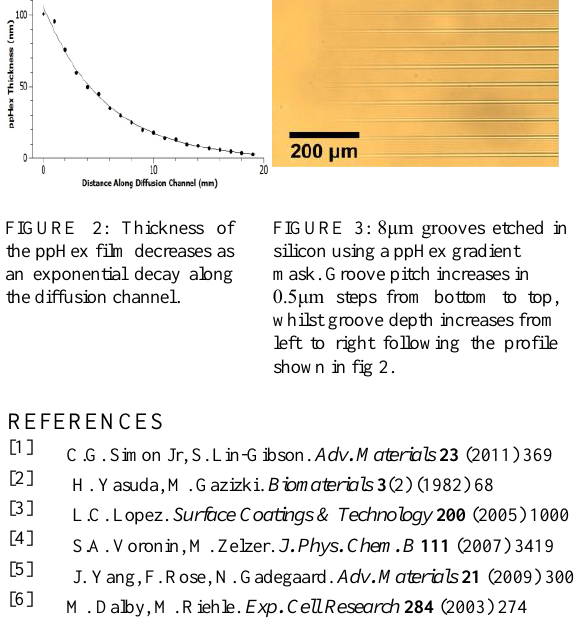
FIGURE 1: Orthogonal gradients of height and pitch can be created on a single sample for high throughput screening of cell-surface interactions. This silicon master can then be used to stamp the pattern into biocompatible polymers, e.g.